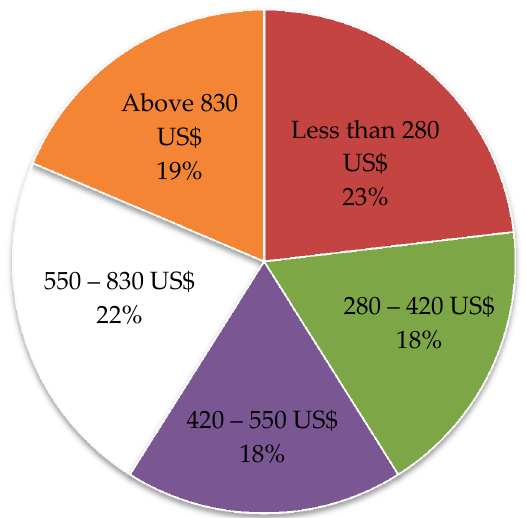
Figure 5. Percentage distribution of families based on family monthly income in US$.